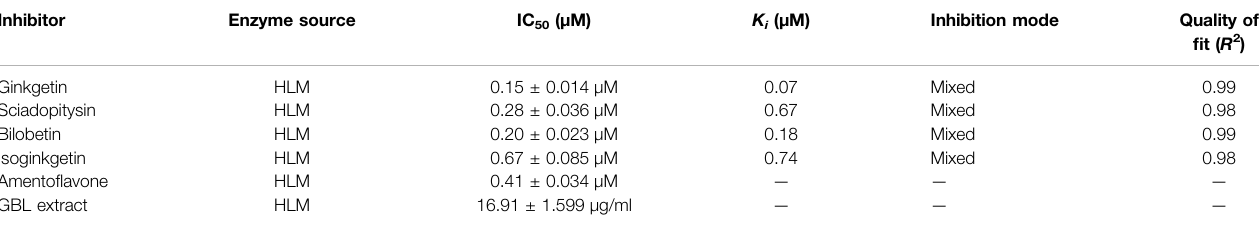
TABLE 2 | The inhibition parameters and inhibition modes of bilobetin, isoginkgetin, sciadopitysin, ginkgetin, Amento fl avone and GBL extract against hUGT1A1-catalyzed NHPN- O -glucuronidation in HLM. Inhibitor Enzyme source Inhibition mode Quality of